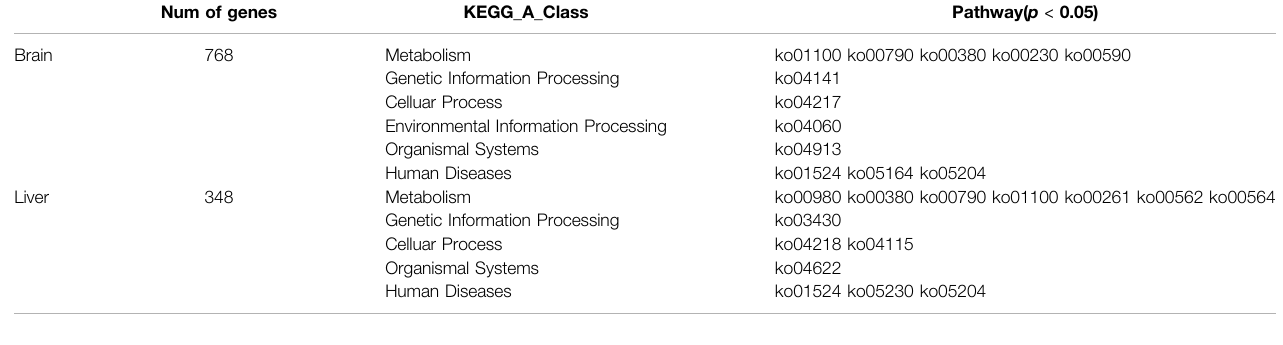
TABLE 4 | Statistical table of signi fi cant enrichment pathway of candidate genes. Num of genes